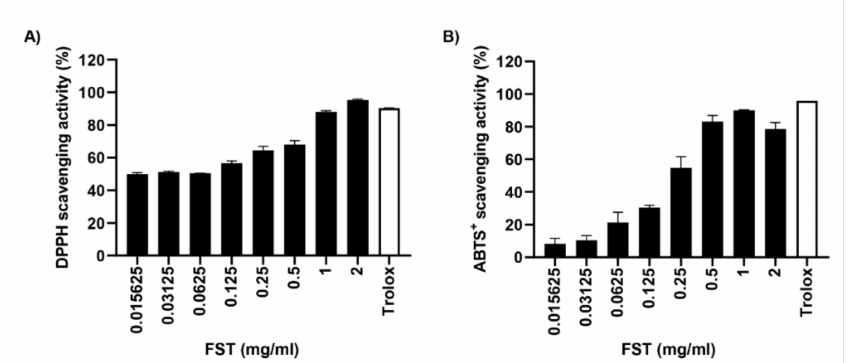
Figure 8. Antioxidant capacity of FST. ( A ) DPPH radical scavenging activity of FST. ( B ) ABTS radical scavenging activity of FST ( B ). Trolox (0.1 mg/mL) was used as the positive controls. Data are represented the mean ± standard deviation of two independent experiments. Table 1. Total phenolic content (TPC) of FST.